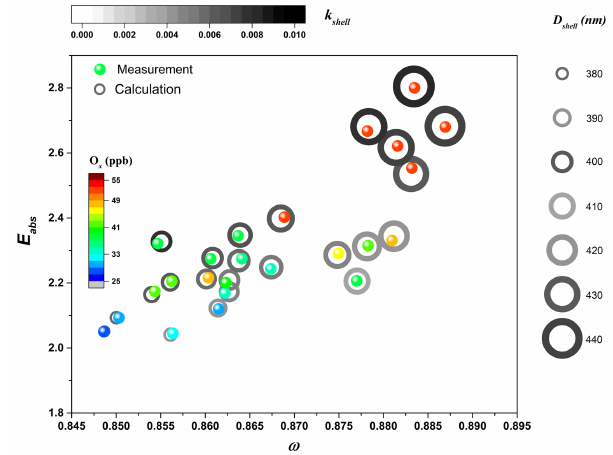
Figure 9. The retrieved diurnal variations in the (b) coating thick- ness ( D Shell ) and (c) imaginary part of the CRI ( k Shell ) of the coated materials, and (d) the relative contribution of the absorption of BC ( f BC ), lensing effect ( f Lens ), and absorption of the shell ( f Shell ). Broadly similar patterns were observed for D Shell , k Shell , f Shell , and (a) O x